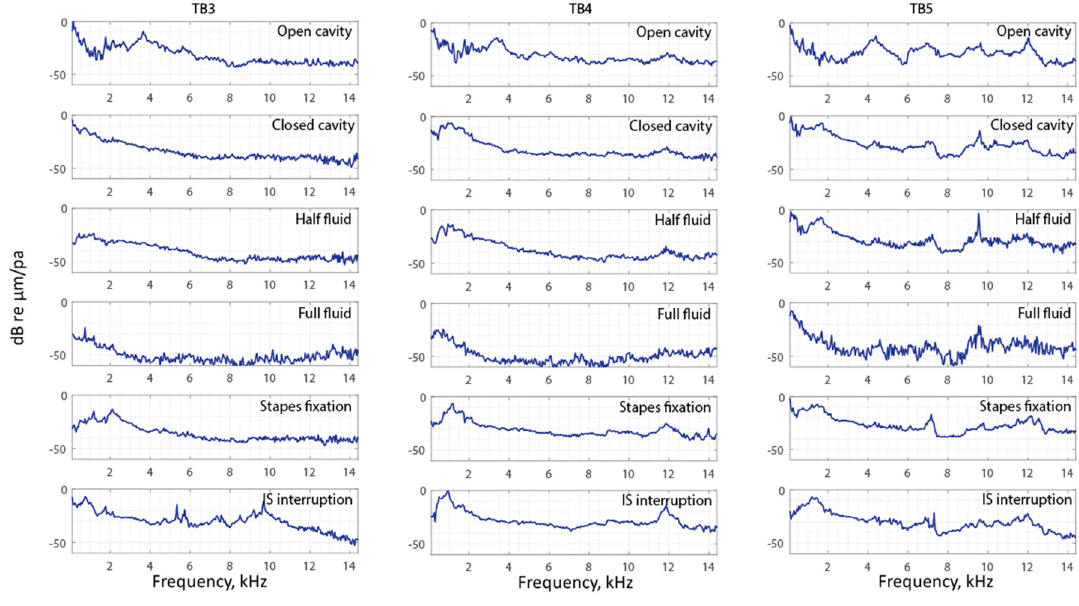
Appl. Sci. 2019 , 9 , x Figure 11. The complex model indicator function of TB3–5 under di ff erent conditions. Figure 11. The complex model indicator function of TB3–5 under different conditions.